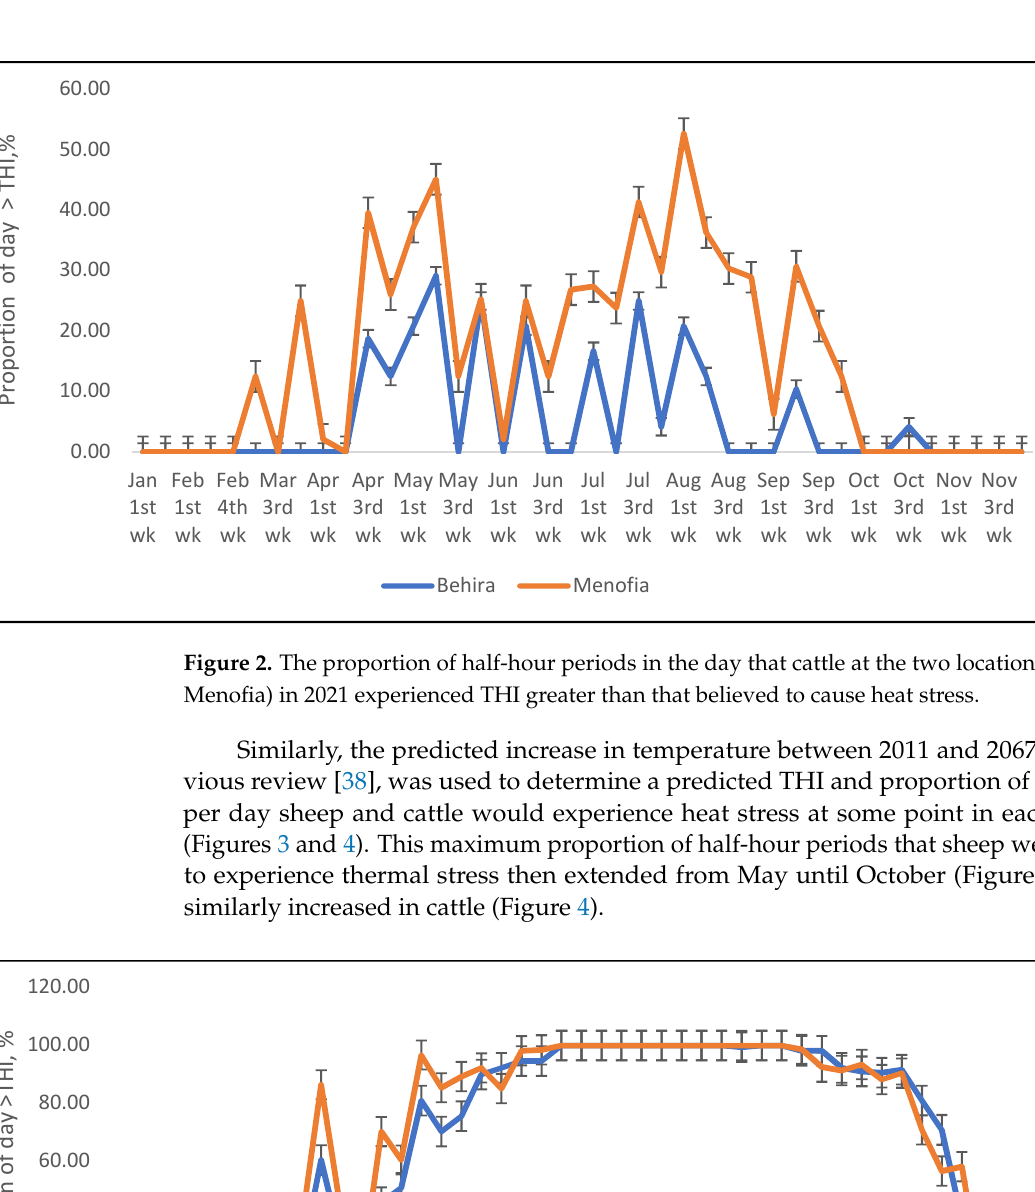
Figure 3. The predicted proportion of half-hour periods of the day that sheep at the two locations (Behira and Menofia) are likely to experience THI greater than that believed to cause heat stress, after addition of temperature increment expected from climate change [38].